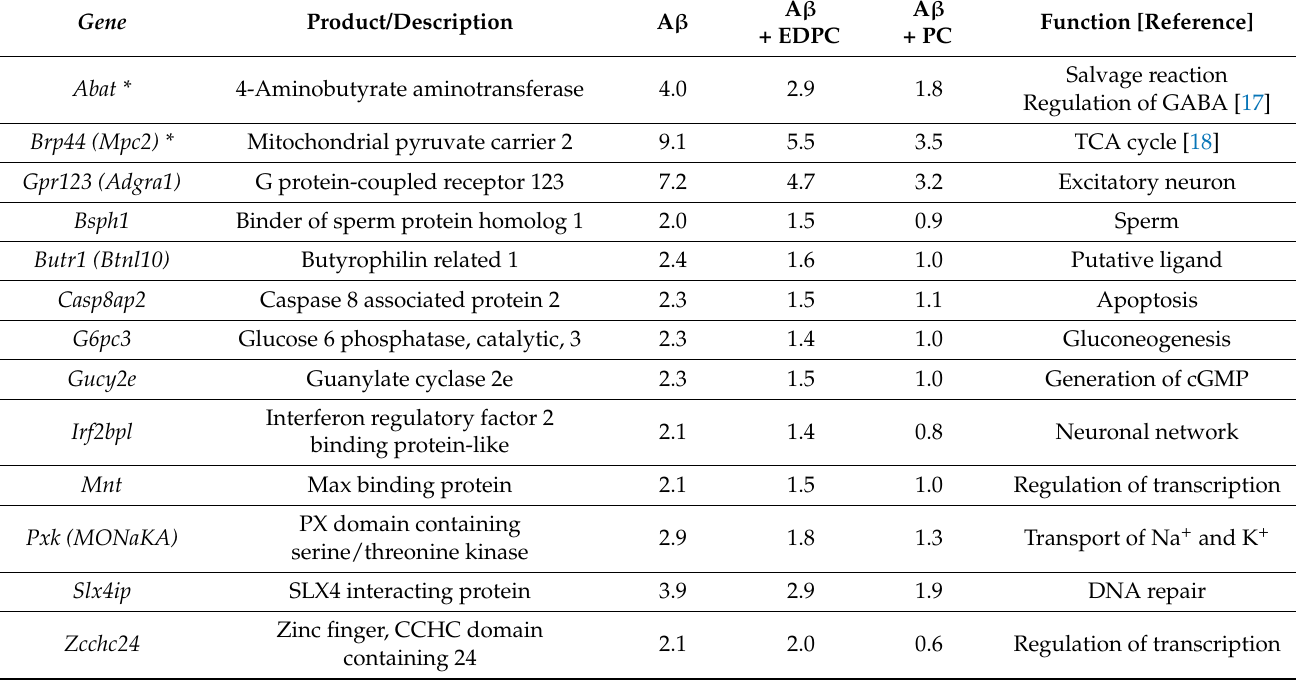
Table 4. Fold change values of the downregulated PC-related genes with respect to the sham group (excluding EDPC- related